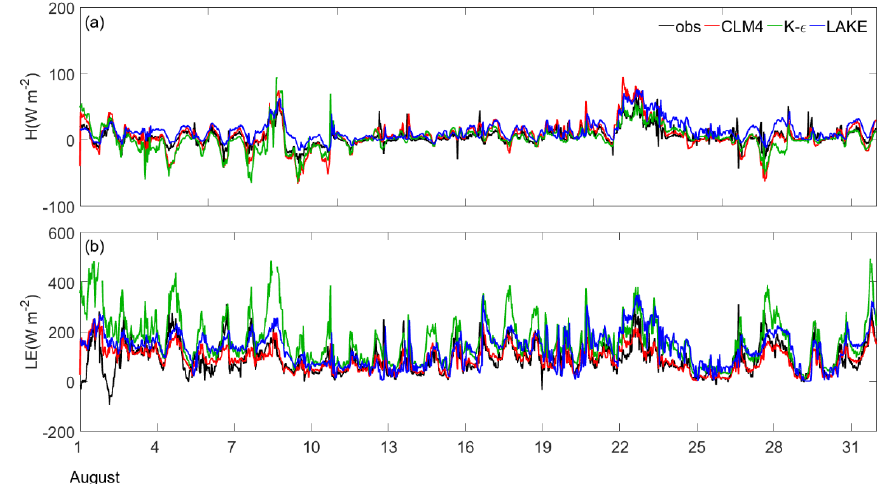
Figure 7. Simulations and observations of the sensible heat flux ( a ) and latent heat flux ( b ) at lake surface every half hour in Lake Taihu in August 2012.